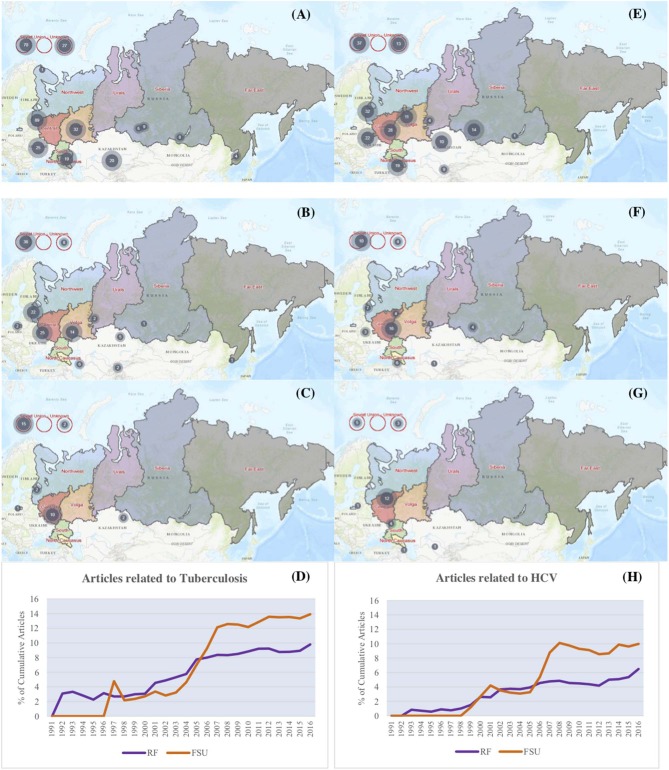
Number of research articles during the study period with a Mycobacteria tuberculosis research theme in 2016 (A), 2005 (B), and 2000 (C) or a Hepatitis C Virus research theme in 2016 (E), 2005 (F), and 2000 (G). (D,H) show the percentage of articles with Mycobacteria tuberculosis and Hepatitis C Virus research themes, respectively, over time.